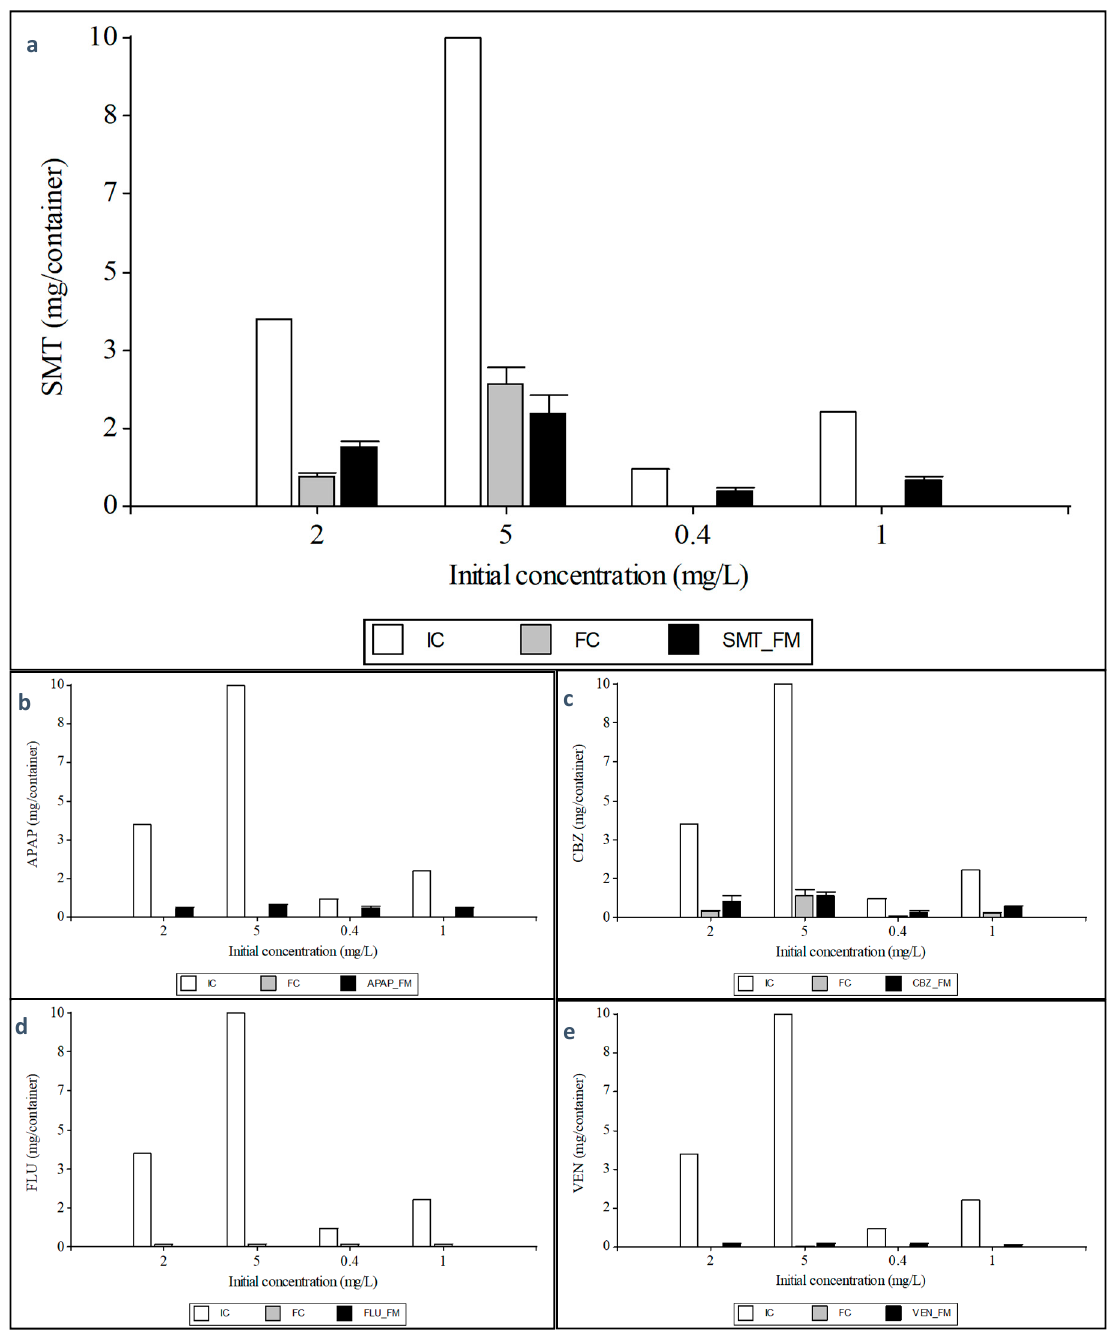
Figure 5. Mass balance of xenobiotics in the culture system. SMT = Sulfamethazine ( a ); APAP = Acetaminophen ( b ); CBZ = Carbamazepine ( c ); FLU = Fluoxetine ( d ); VEN = Venlafaxine ( e ); IC = Initial content in the culture medium; FC = Final content in the culture medium; XB_FM = Xenobiotic content in the total fresh plant material. The values 2 and 5 on the x -axis represent the singly xenobiotic concentration and the values 0.4 and 1 represent each xenobiotic concentration in a mixture of the five xenobiotics in milligram per liter. Values show the mean ± standard error of three biological replicates per treatment.